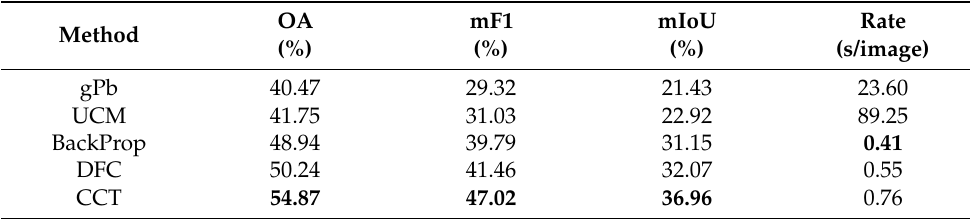
Table 2. Quantitative results of the comparative methods on Shanghai dataset. The best values are in bold.